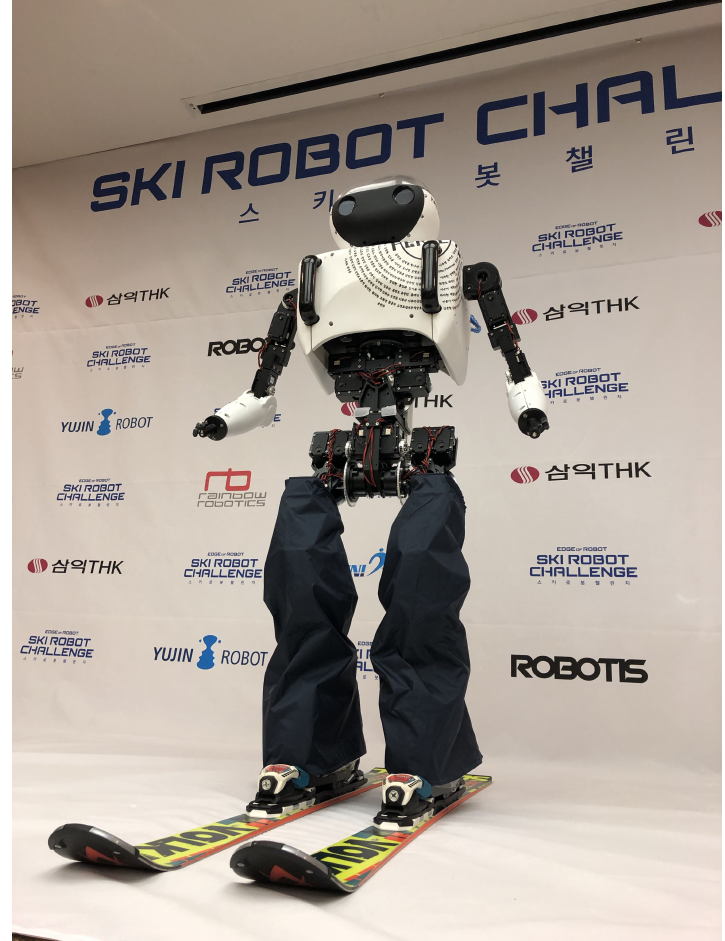
Figure 1. Skiing robot